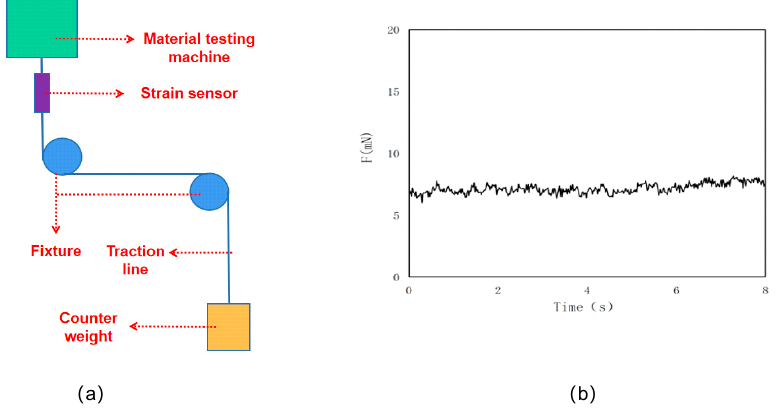
Figure 3. Schematic diagram of the process of producing the friction between the sliding block and the concrete surface through the friction between the traction wire and the fixed pulley. Among them, ( a ) is the calibration process of the test device, and ( b ) is the change curve of friction with time.